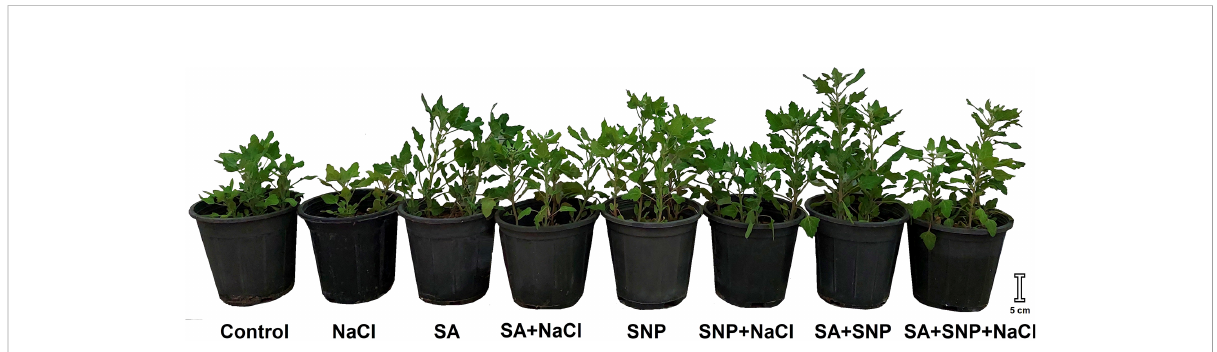
FIGURE 1 Illustration of Chenopodium quinoa under different treatments of salicylic acid (SA) and sodium nitroprusside (SNP), and salinity stress at harvesting